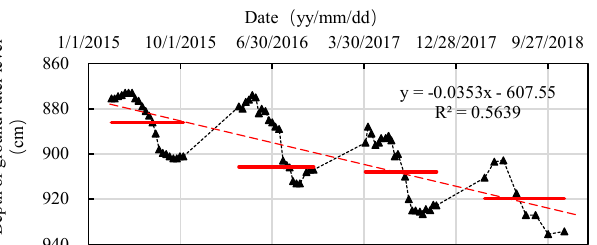
Figure 5. Dynamic diagram of groundwater burial depth. The red lines are the annual mean value for the groundwater depth, the red dotted line is the trend line for the annual groundwater level fluctuation, and the points represent the groundwater level monitoring depths .